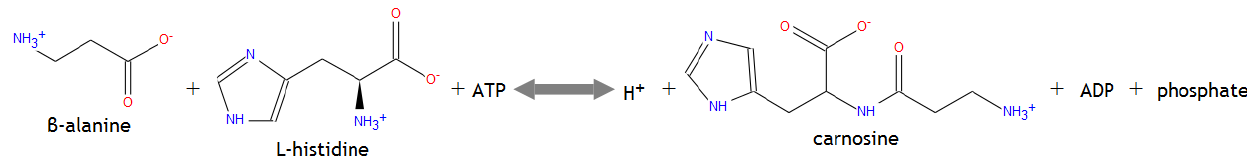
Figure 2. Intramuscular carnosine